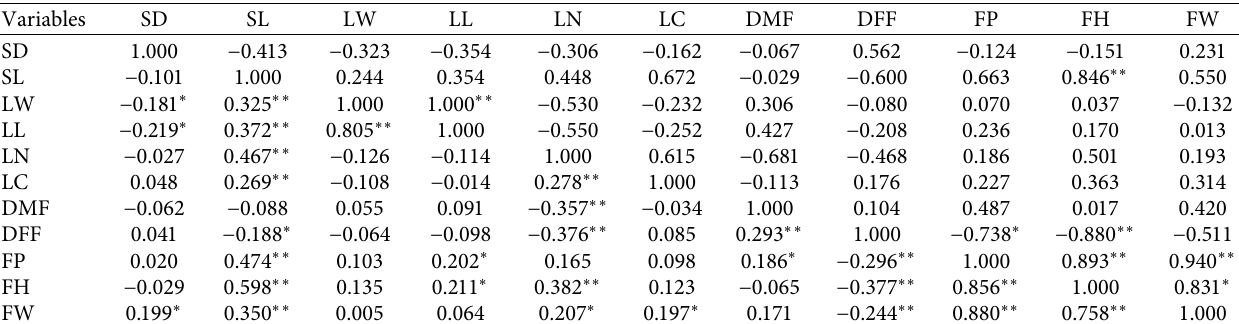
Table 3: Genotypic (upper) and phenotypic (lower) correlations among agronomic and yield traits of melons. Variables SD